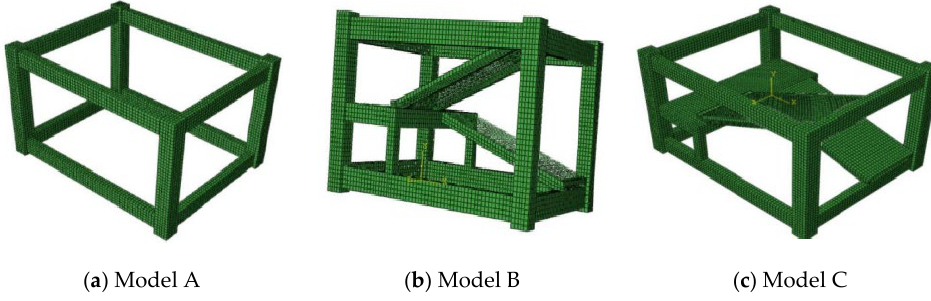
Figure 1. Structure and modeling method of the sliding bearing.